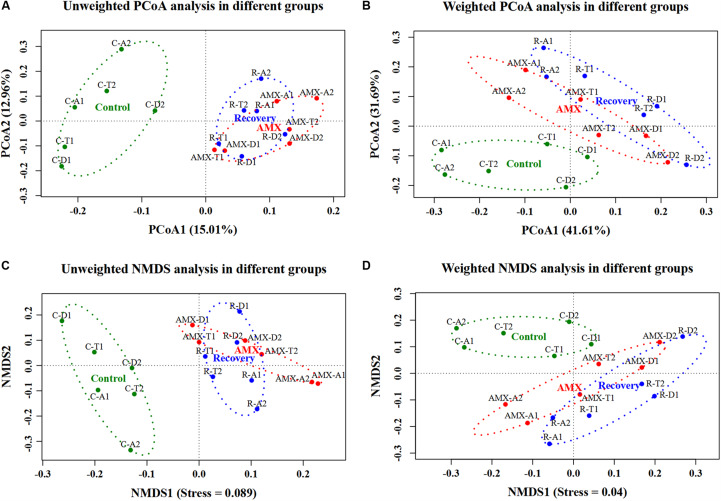
Effects of AMX treatment on gut microbiota beta diversity of the control (green), AMX (red), and recovery (blue) groups. Unweighted (A) and weighted (B) PCoA, and unweighted (C) and weighted (D) NMDS of UniFrac distances of samples in three groups (control, AMX, and recovery).